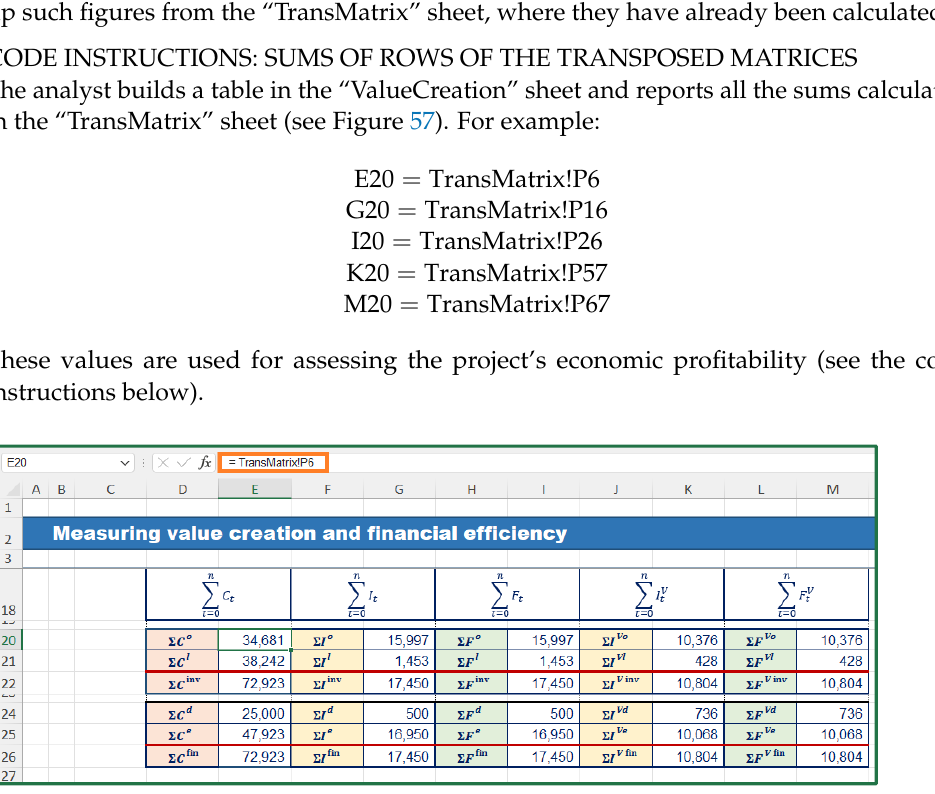
Figure 57. The table in the rows 18:26 contains the sums of the Transposed Matrices rows (“ValueCreation” sheet). CODE INSTRUCTIONS: ABSOLUTE AND RELATIVE MEASURES OF ECONOMIC